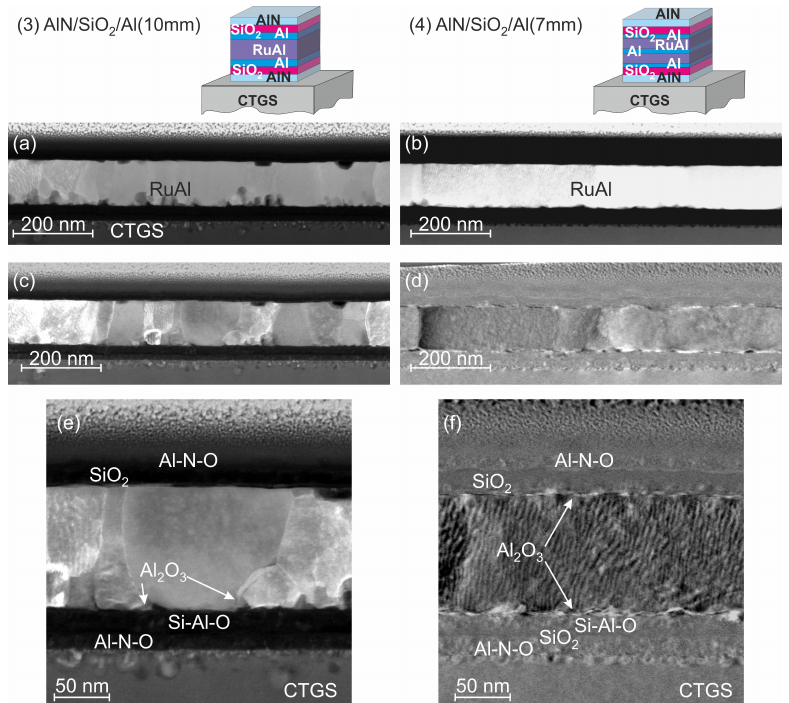
Figure 12. STEM images of layer stacks (3)-AlN/SiO 2 /Al(10 nm) and (4)-AlN/SiO 2 /Al(7 nm) on CTGS after annealing at 900 ◦ C in HV: ( a , b ) with predominant chemical contrast; ( c – f ) with predominant orientation